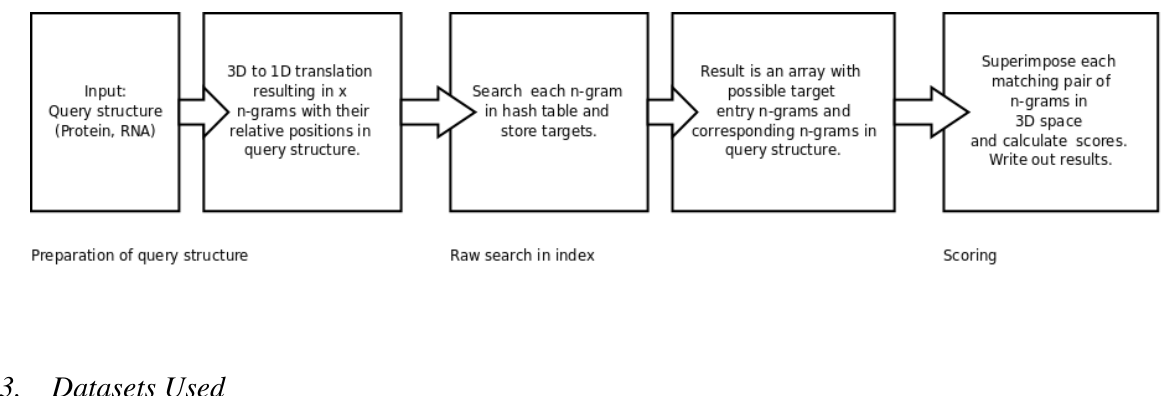
Figure 3. An informal diagram showing the steps performed when a query structure is searched against a set of target structures in an